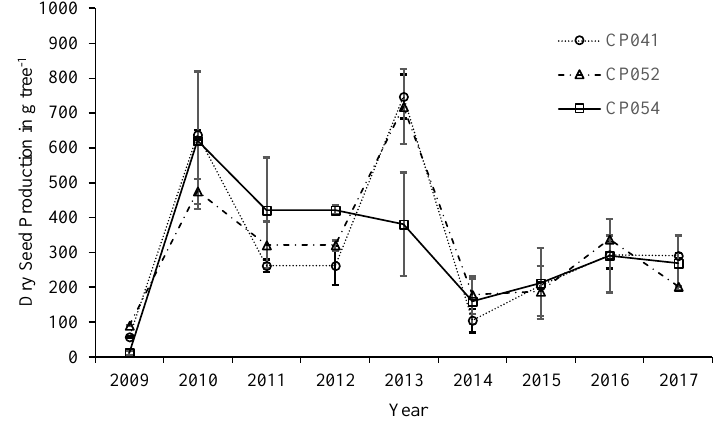
Figure 2. Dry seed production per tree for three jatropha INIAP accessions during the years 2009 – 2017 at INIAP Portoviejo Research Station, Ecuador. Vertical bars indicate the standard error.